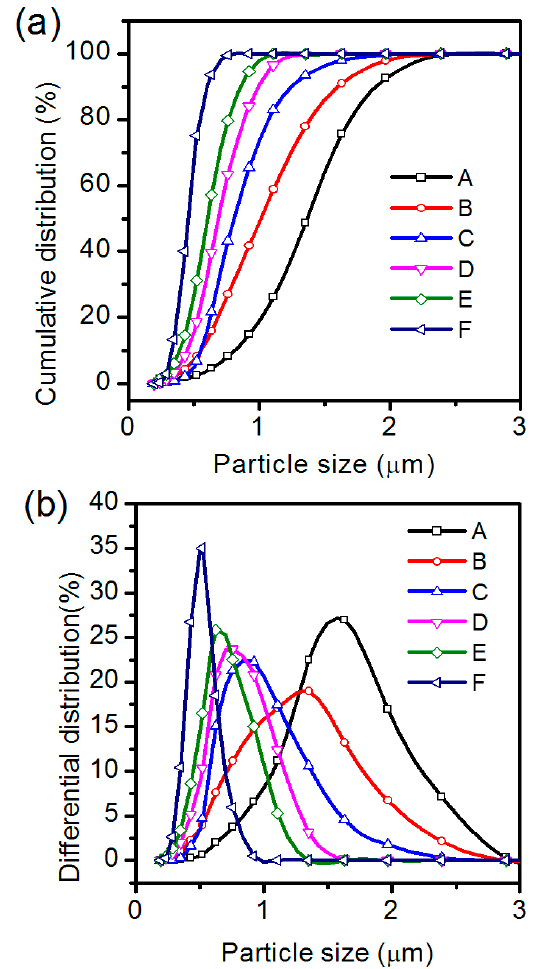
Figure 5. ( a ) Cumulative particle-size distribution curves and ( b ) differential particle-size distribution curves of the BT powders prepared by sand-milling the pristine BT sample for various times (t/min): (A) 1 min, (B) 10 min, (C) 20 min, (D) 30 min, (E) 40 min and (F) 60 min.